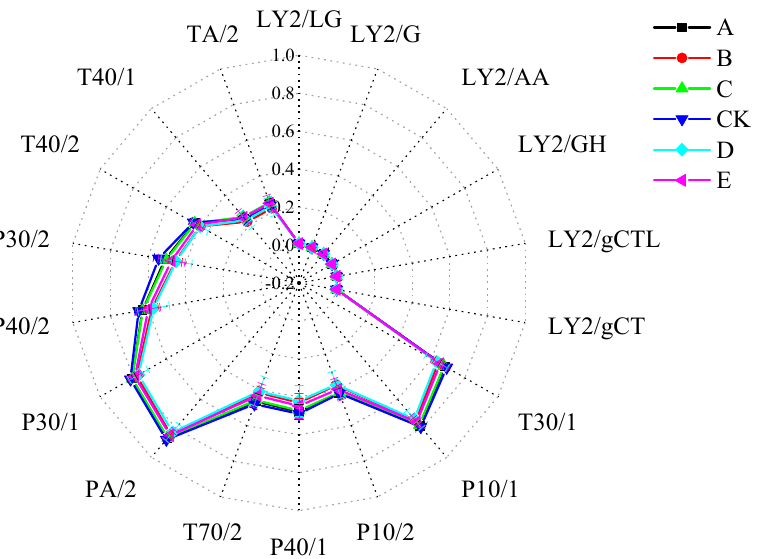
Figure 8. Effect of vanillin concentration on the radar fingerprint of E − Nose responses to carp-muscle flavour volatiles. Note: A, B, C, CK, D, and E represent vanillin concentrations of 0.50, 0.75, 1.00, 0 (control), 1.25, and 1.50 g/L, respectively.